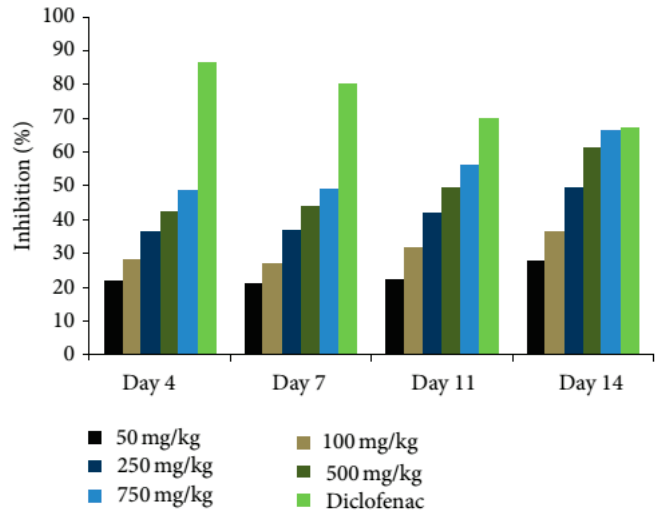
Figure 5. Inhibition of paw edema in adjuvant arthritis with different concentrations of methanolic extract of G. kurroo Royle (Dose and time dependent) (Source: [85]).